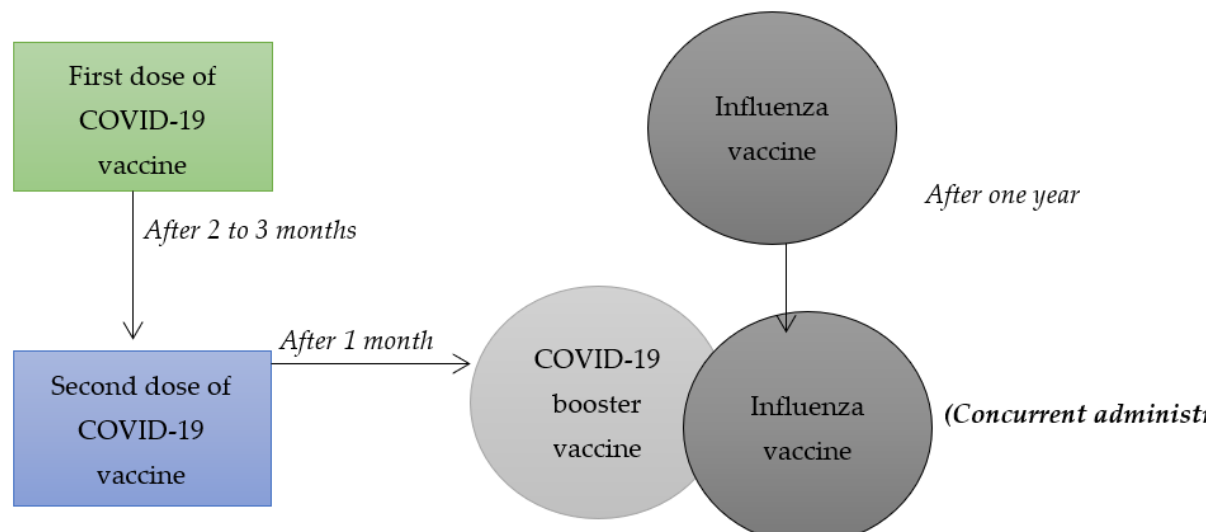
Figure 1. Combining influenza vaccine with COVID-19 booster